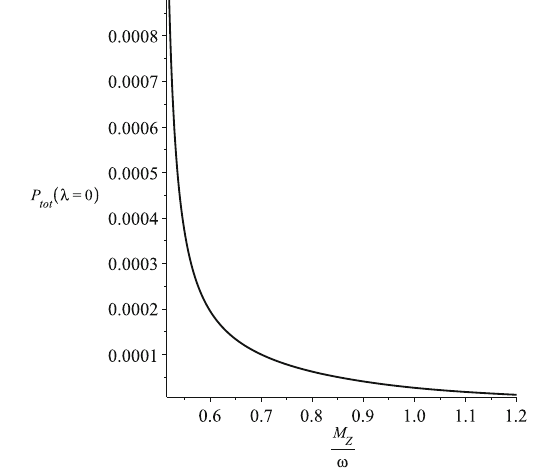
Fig. 10 P tot (λ = 0 ) as a function of parameter M Z /ω